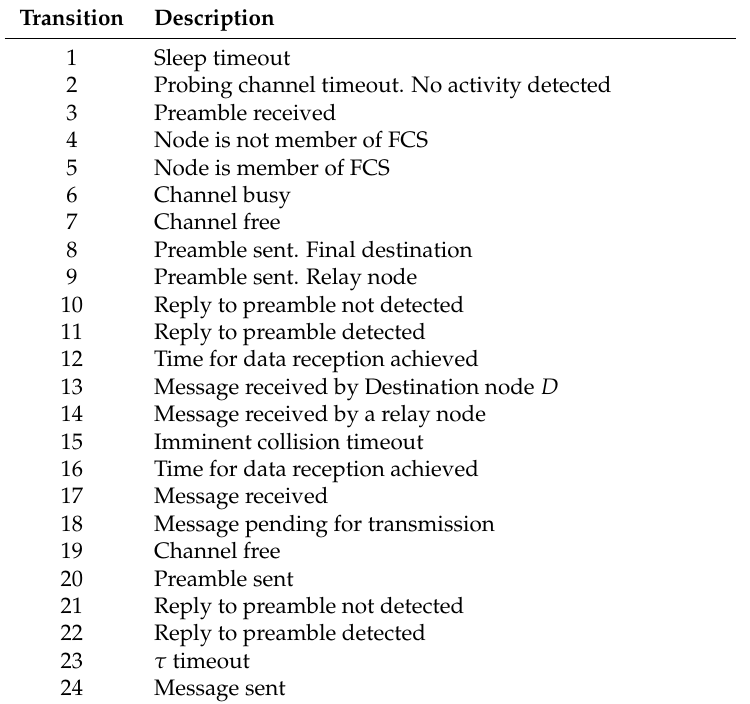
Table 2. List of all transitions in the state